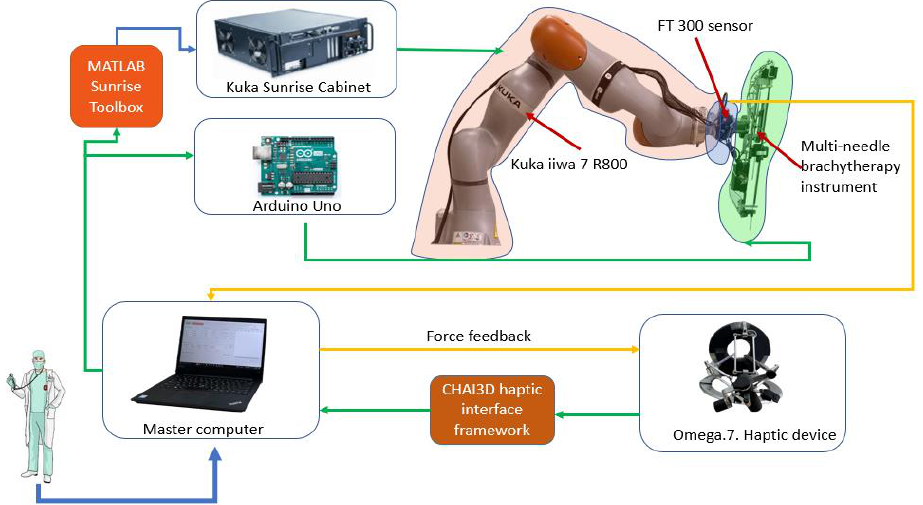
Figure 1. The robotic system architecture.